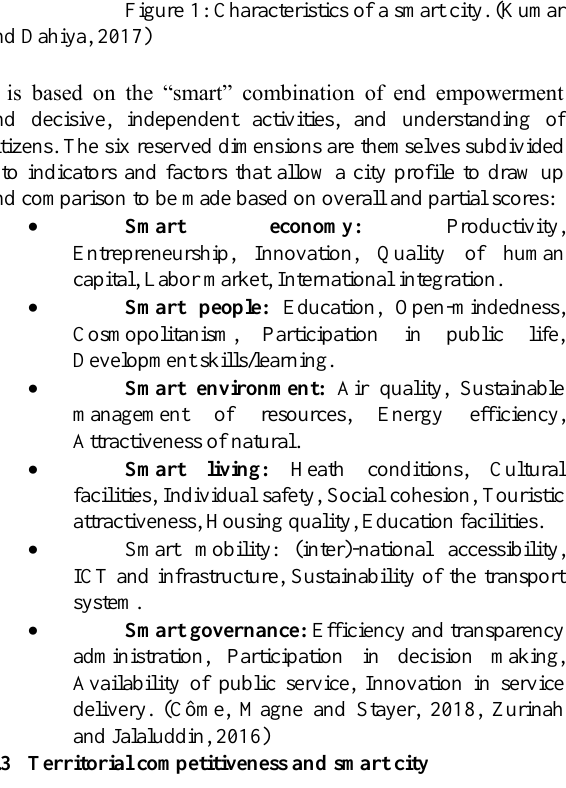
Figure 1: Characteristics of a smart city.